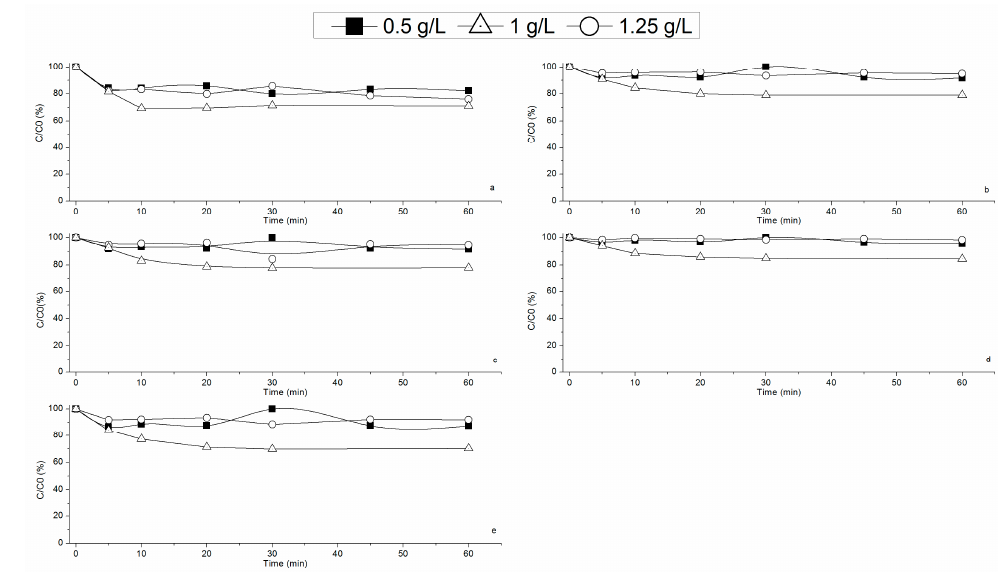
Figure 4. Effect of the catalyst load on the acid degradation ( a ) 3,4-dihydroxybenzoic acid, ( b ) 4-hydroxybenzoic acid, ( c ) 3,4-dimethoxybenzoic acid, ( d ) 3,4,5-trimethoxybenzoic acid and ( e ) cinnamic acid. (H 2 O 2 = 50 mg/L; pH = 3.4).